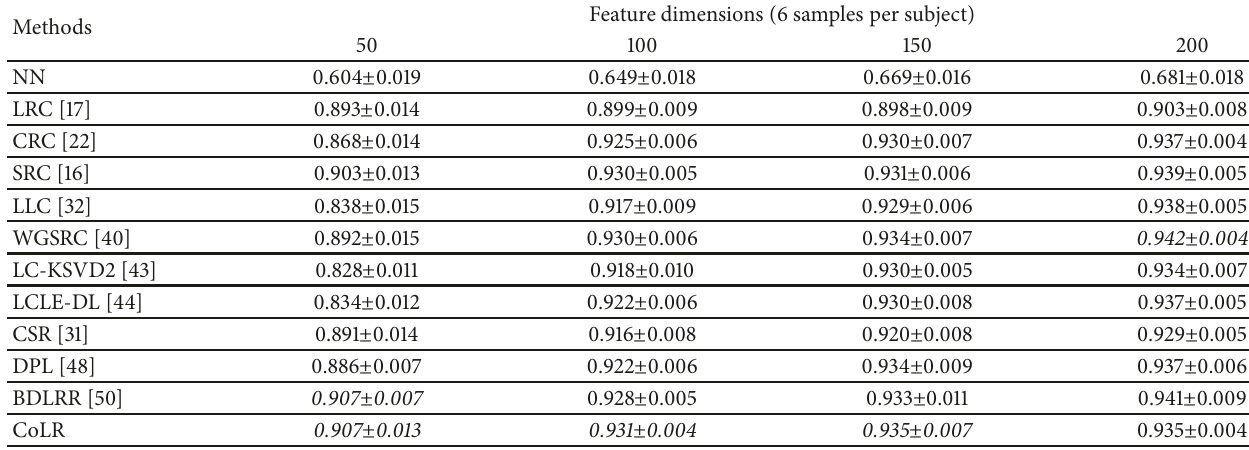
Table 8: Recognition rates on the CMU PIE dataset under different feature dimensions.